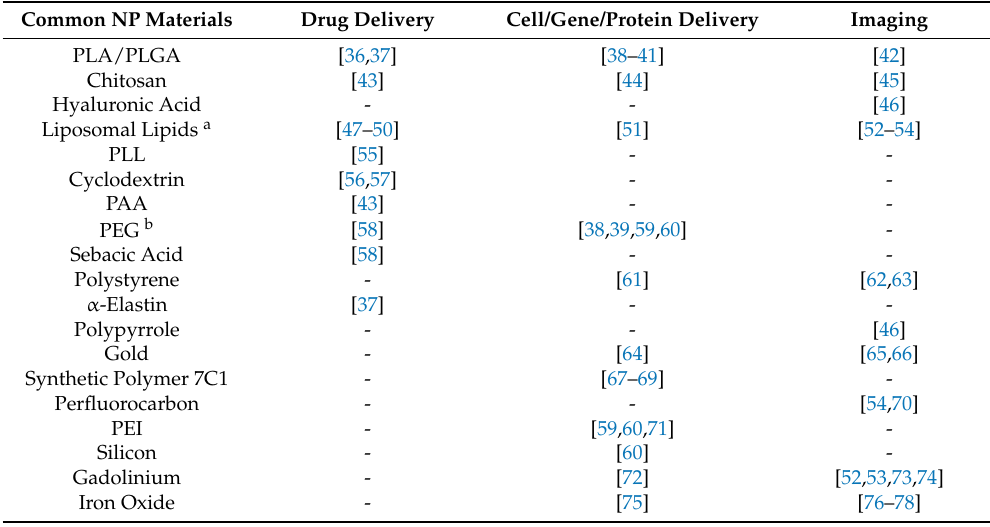
Table 1. Summary of common materials used to fabricate NPs used in atherosclerosis research studies selected for this